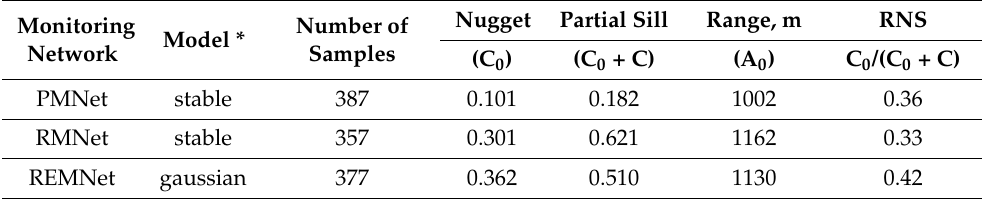
Table 2. Semivariogram model parameters for analysed monitoring networks.